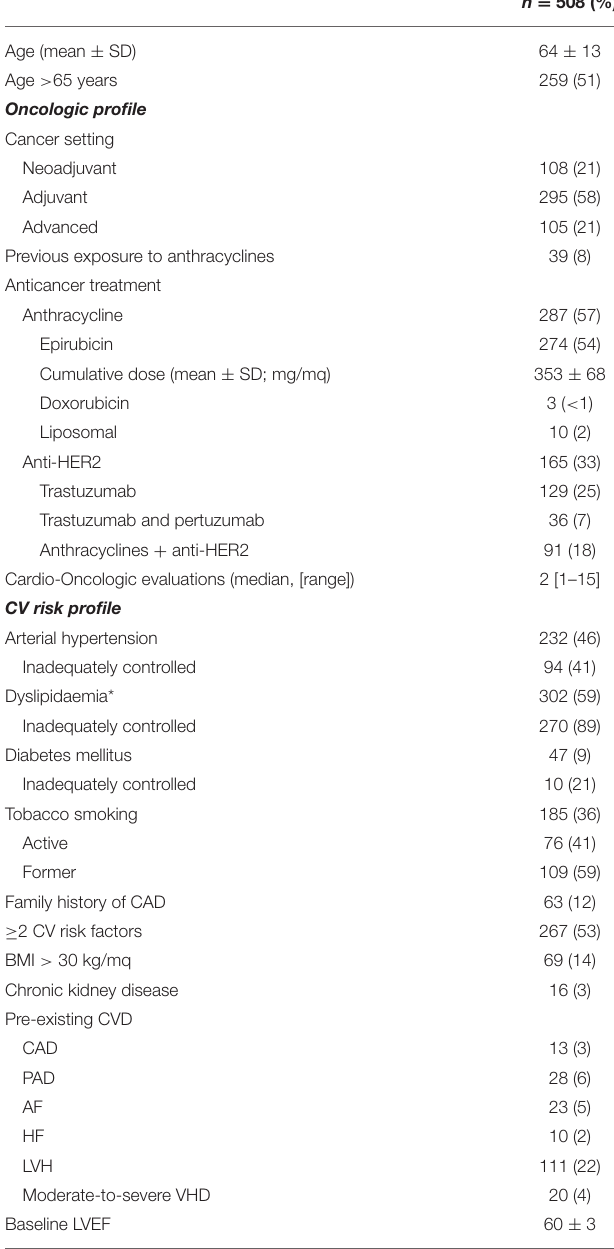
TABLE 1 | Characteristics of study